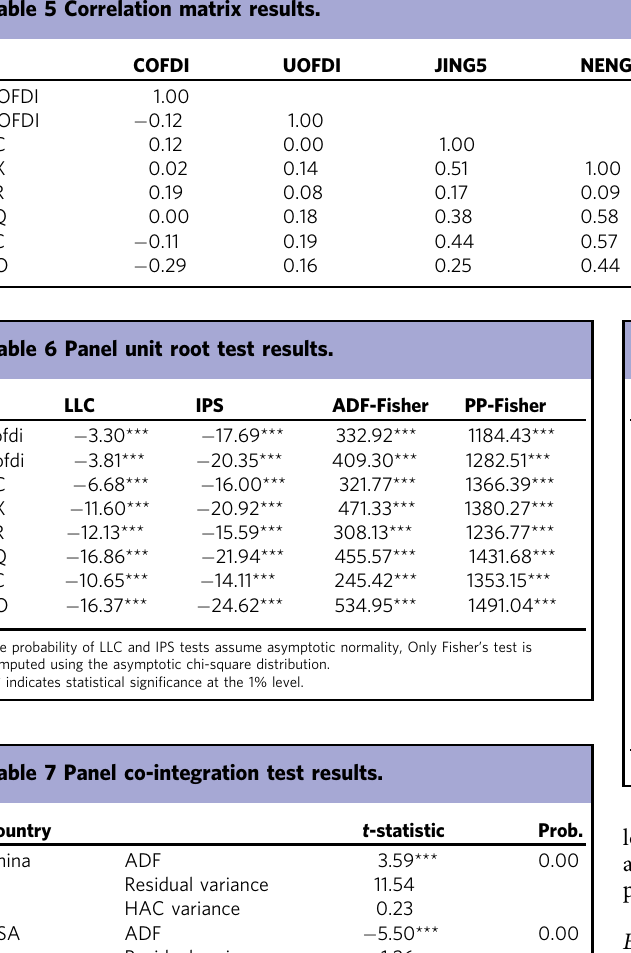
Table 5 Correlation matrix results.